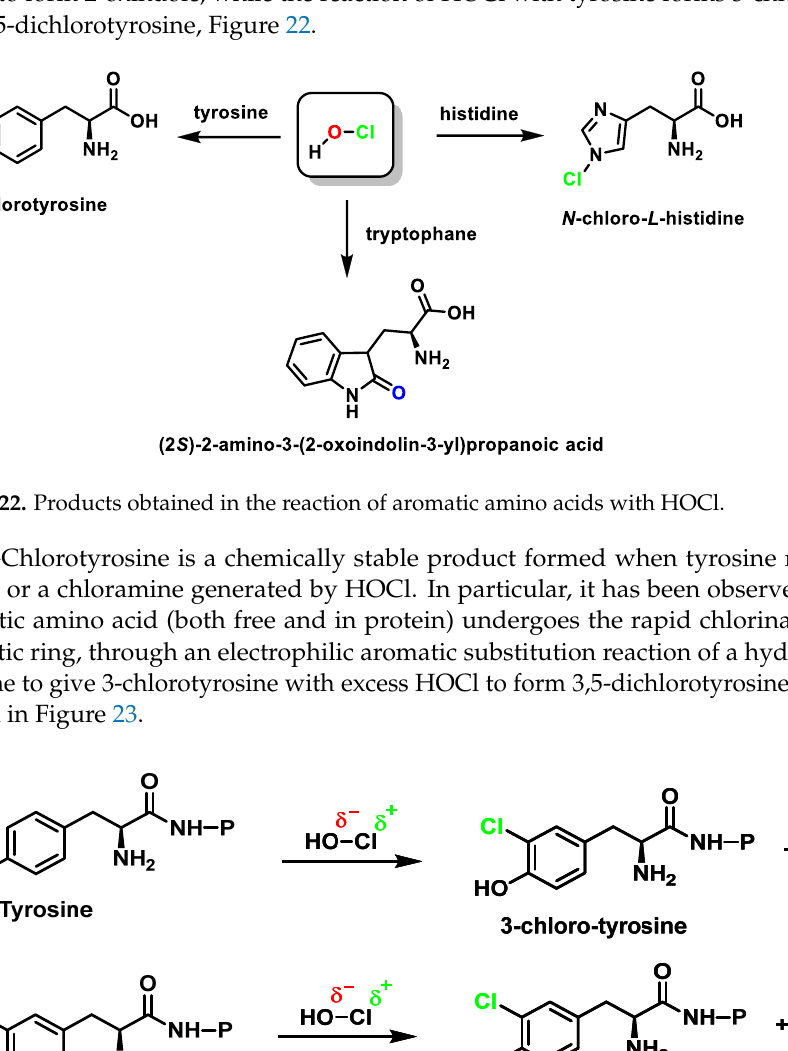
Figure 21. Schematic the mechanism of formation of N -chloro- α -amino acids from amino acids in-